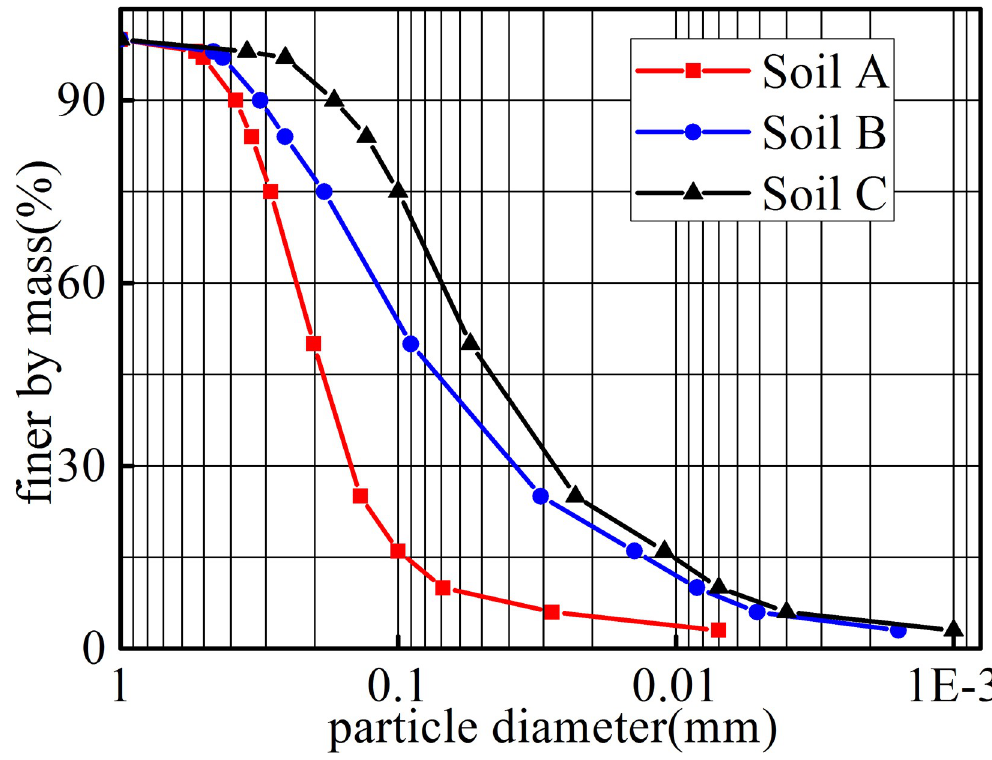
Fig 3. Particle size distribution for test